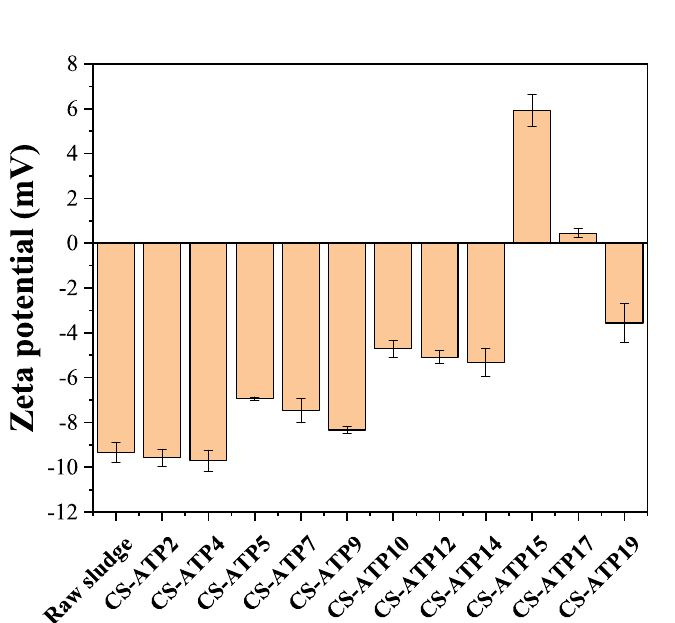
Figure 3. The zeta potentials of the sludge supernatants conditioned by St-CTA in conjunction with ATP using different